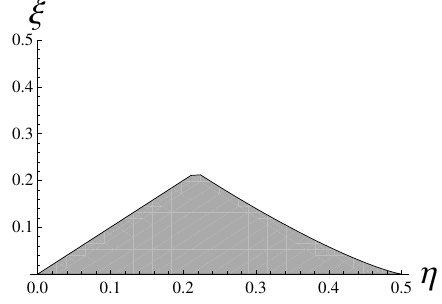
Figure 6. Region 0 < ξ < η, described by the inequality